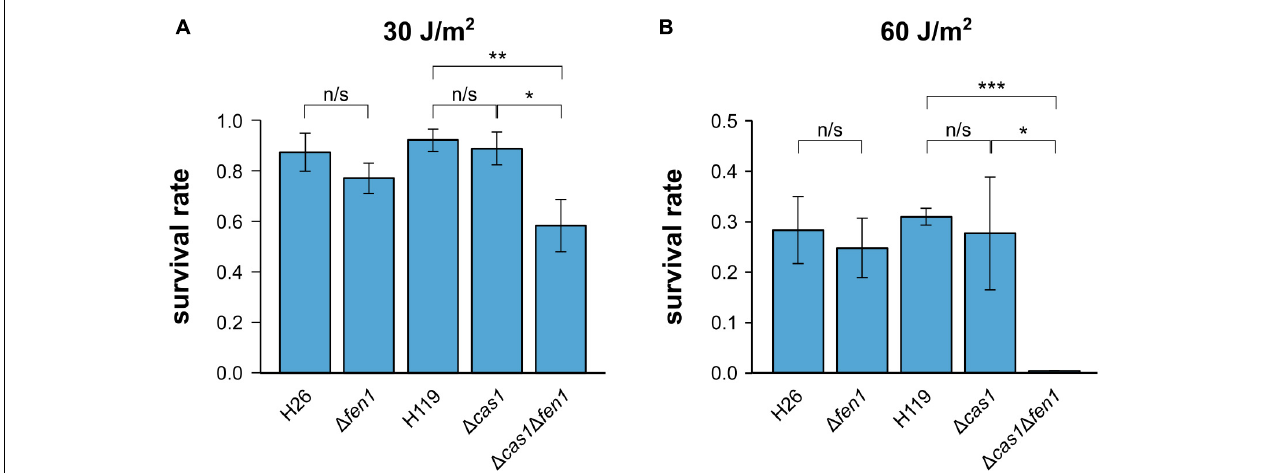
FIGURE 2 | Survival rates of Haloferax volcanii exposed to UV radiation. H. volcanii strains were grown to the mid-log growth phase, spotted on Hv-YPC plates and exposed to UV radiation [ (A) 30 J/m 2 , (B) 60 J/m 2 ]. After growth, survival rates were calculated by dividing the number of CFUs determined for the exposed strains by the number of CFUs of an unexposed control. Asterisks indicate significant differences ( t -test) between the survival rates based on three independent experiments; ***: highly significant (p-value < 0.001), ** very significant (p-value < 0.01), * significant (p-value < 0.05), n/s = not